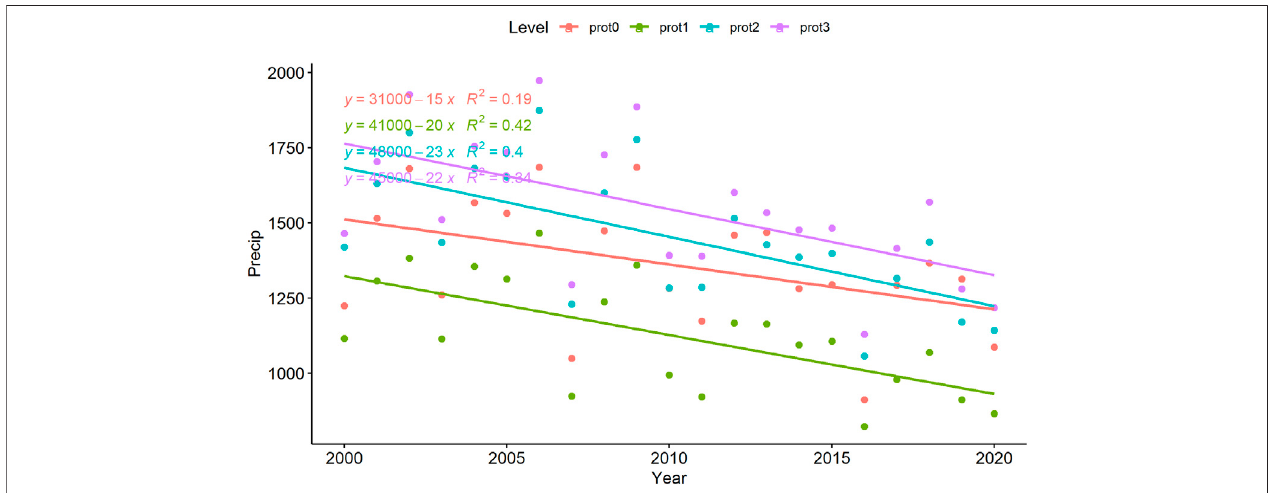
FIGURE 7 | Annual precipitation change for each level of protection. prot0: unprotected area, prot1: National Reserve, prot2: National Park, prot3: Strict Nature Reserve.